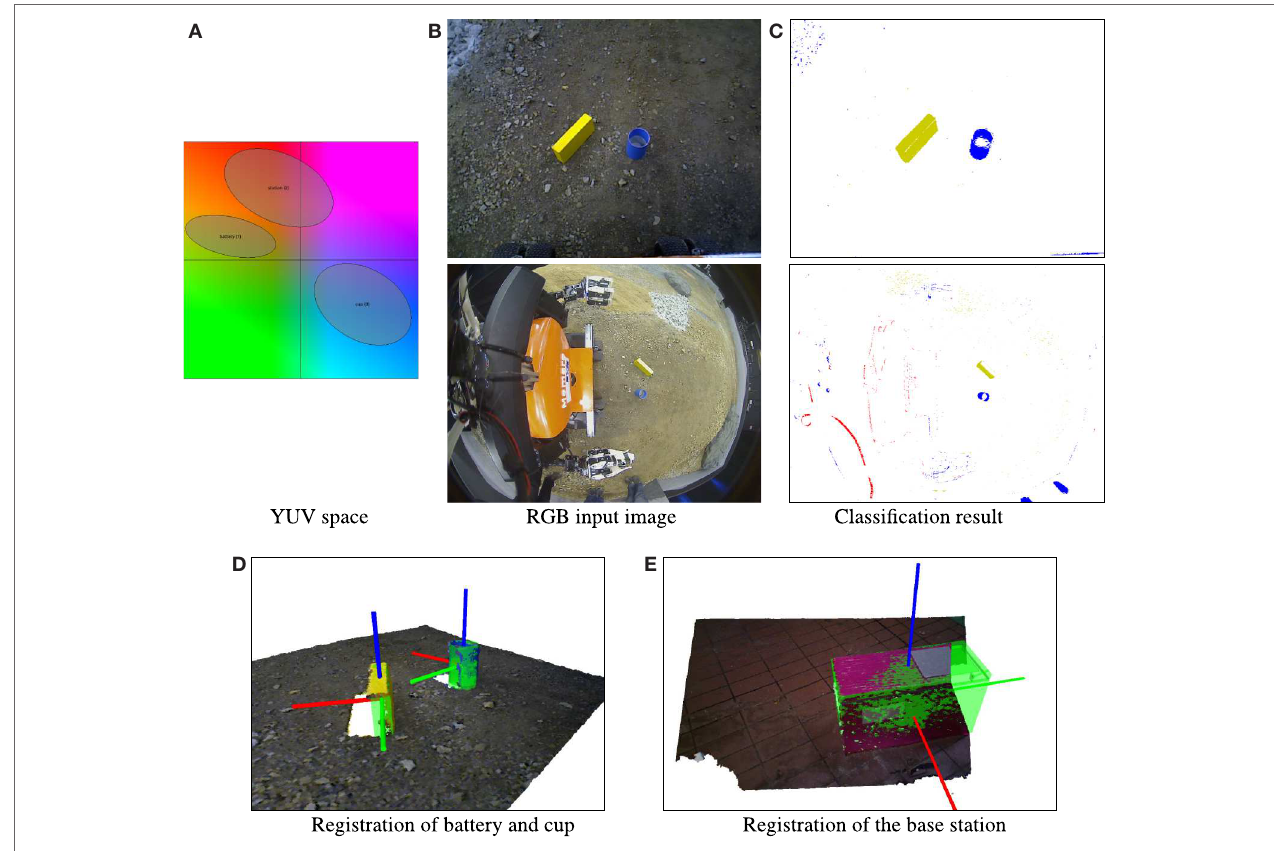
FIGURE 7 | Object perception . (A) Classification ellipses in UV space. (B) RGB input image (first row: Xtion camera, second row: RGB wide-angle camera). (C) Pixel classes (white = unknown). (D) RGB-D point cloud showing the cup and battery objects on SpaceBot Camp terrain. The registered models are shown in green. (E) Registration of the base station. Although neither the left nor the right face is visible, the pose ambiguity is resolved correctly.